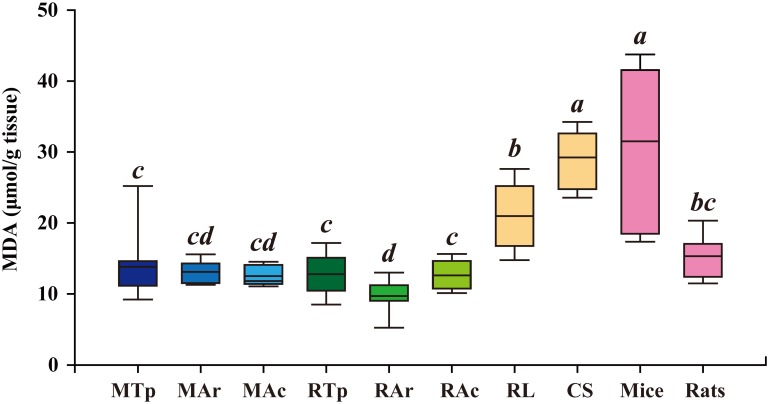
Malondialdehyde (MDA) levels in brain tissue.Y-axis represents MDA levels (μmol/g tissue). M. ricketti bats at torpor, arousal, and active states are indicated as MTp, MAr, and MAc, respectively. R. ferrumequinum bats at torpor, arousal, and active states are indicated as RTp, RAr, and RAc, respectively. Brain MDA levels of R. leschenaultia (RL), C. sphinx (CS), mice, and rats are also shown. Data are presented as box plots that show the mean, 25/75 percentiles (box), and 10/90 percentiles (bars). Values of group means are represented by italicized letters and are in the order of a > b > bc > c > cd > d. The difference in value is significant (P < 0.05) between different letters.